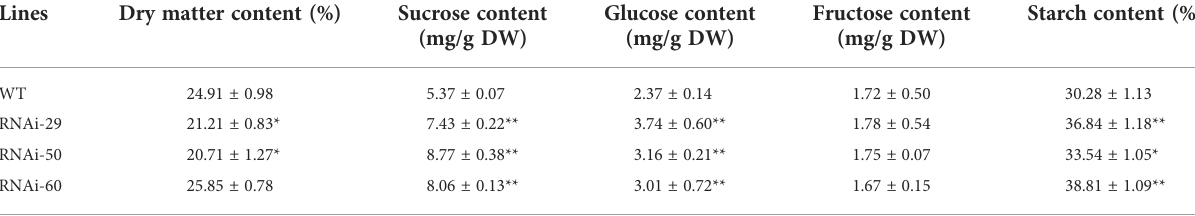
Datarepresent mean±SD ofatleastthreebiologicalreplicates. Asterisks indicate signi fi cantdifferencesincomparison withtheWT asdeterminedbyStudent ’ st-test:**P<0.01,*P<0.05.